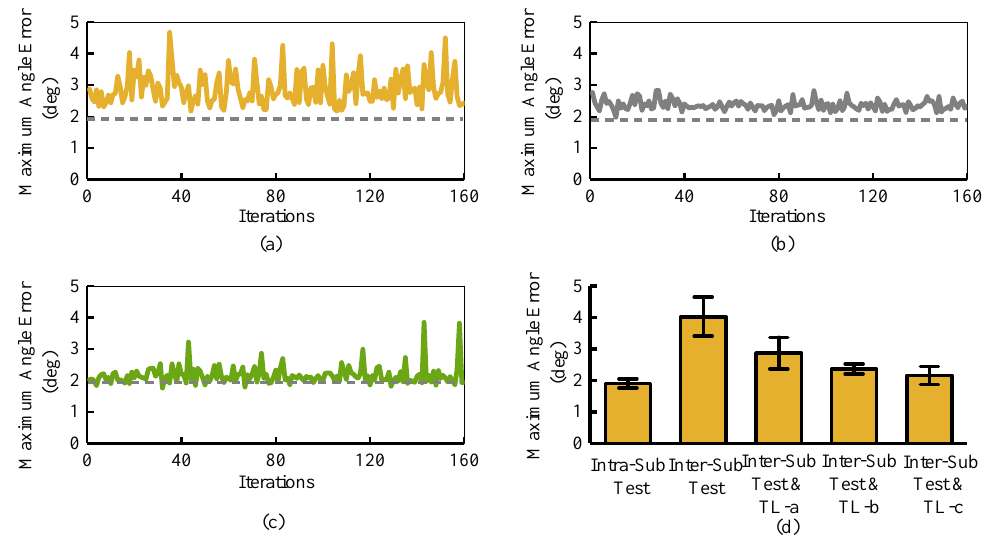
Figure 13. The 101.25 ms advanced motion prediction and adaptation results for two comparative experiments on online adaptation network. ( a ) Adjusting the parameters of FC3 layer; ( b ) Adjusting the parameters with even index of FC3 layer; ( c ) Adjusting the parameters of FC4 layer; ( d ) The adaptation results of angle prediction. Different parameters chosen to be adjusted are in the motion prediction network. The ‘-a’,‘-b’, and ‘-c’ in sub-figure ( d ) represent the adaptation network adjusts all the parameters of the FC3 layer, the parameters of even index in the FC3 layer, and the parameter in the F4 layer,